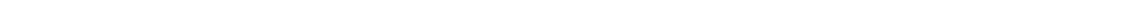
Fig. 5 GSK3 is required to establish polarity and to form lamellipodia in migrating neural crest cells. a , b GSK3 inhibition increases nuclear RAC1 and reduces cytoplasmic RAC1 in neural crest cells. a In control explants, RAC1 (red) is high in the nucleus while in the cytoplasm it is enriched at cell protrusions (arrowheads). Actin was labelled with phalloidin (green). b In BIO-treated explants, nuclear RAC1 is high but cytoplasmic staining is lost (white arrowheads). c Relative levels of Rac1 fl uorescence in the nucleus or the cytoplasm ( n = 9) ** p ≤ 0.001 and *** p ≤ 0.0001, two-tailed unpaired t -test. d – e GSK3 inhibition reduces the expression of cdc42 in neural crest cells. d Cdc42 is cytoplasmic and perinuclear in neural crest cells. e BIO-treated explants lose cdc42 staining. f – g In controls, anti-lamellipodin (green) stains the ruf fl ed edge of migrating cells. g In contrast, BIO-treated cells show increased total lamellipodin throughout the cell, losing speci fi c localization at the cell edge. Scale bar, 20 μ m. h , i Bright- fi eld still images from controls ( h ) or BIO-treated samples ( i ) ( n = 3 explants with ≥ 10 cells per explant). Control images show cells form fan-shaped stable lamellipodia and ready to migrate away from the cluster ( h , white arrowheads). In treated cells, despite some cells form stable lamellipodia as found in controls ( i , light blue arrowheads), cells predominantly formed an irregular protrusion that tend to retract ( i , green arrowheads). Scale bar, 500 μ m (see corresponding Supplementary Movies 6, 7). j Graph showing the number of cells delaminating from the premigratory neural crest cell clusters in 2 h. * p ≤ 0.05 and ** p ≤ 0.001, two-tailed unpaired t -test. k Percentage of delaminating cells that show stable (persistent) lamellipodia or unstable (short-lived) lamellipodia. l , m Still images of time-lapse showing control mouse neural crest cells ( l , supplementary movies 3,5) and pCAAG::creER tm ;GSK3 α fl / fl ; GSK3 β fl / fl ; Rosa mtmg/ + deleted cells ( m , supplementary movie 4, 5). Upon tamoxifen-induced knockout of GSK3, the neural crest cells are unable to migrate and the cell edge does not